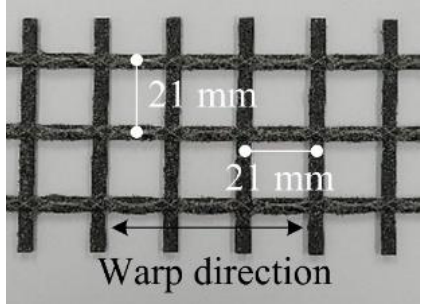
Figure 1. Carbon textile grid.